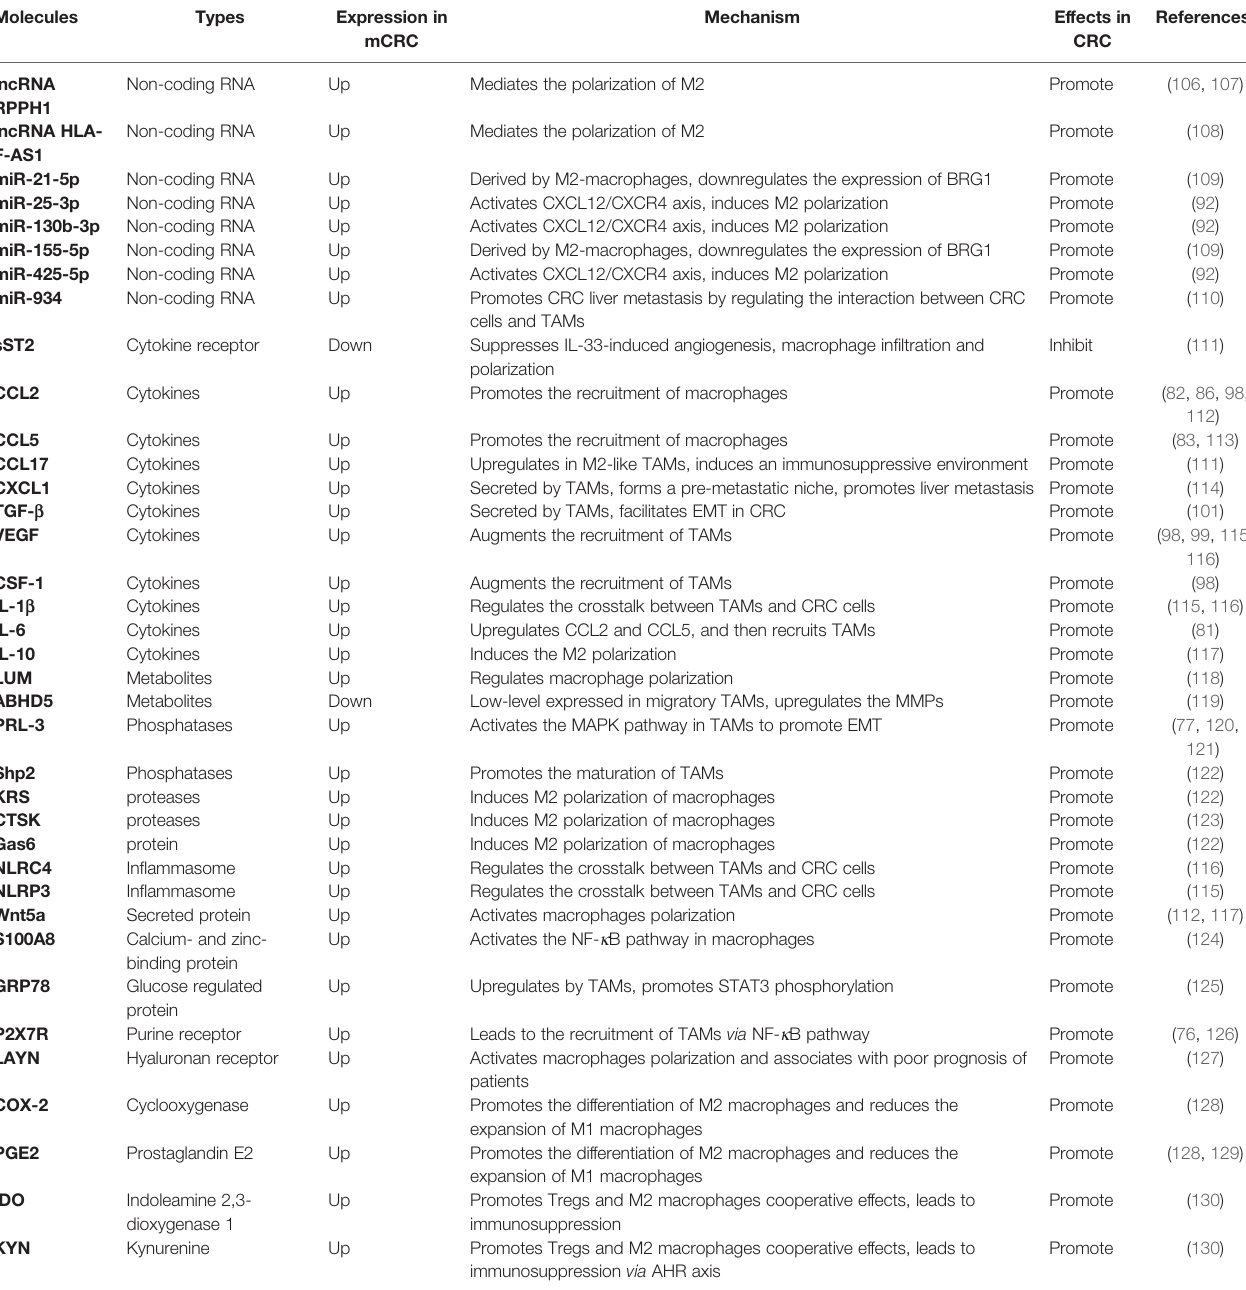
TABLE 1 | Molecules related to TAMs in CRC metastasis.